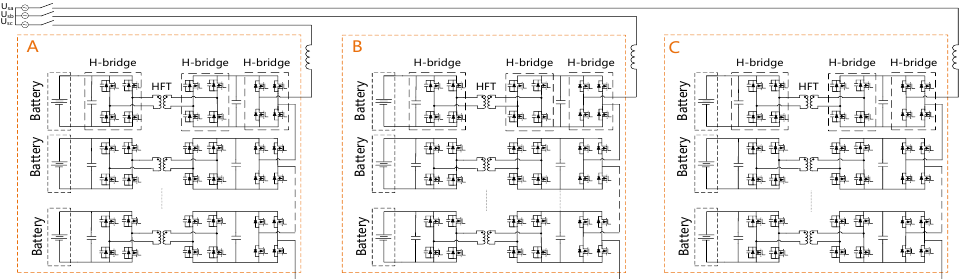
Figure 1. Topology of high-frequency isolated energy storage converter.